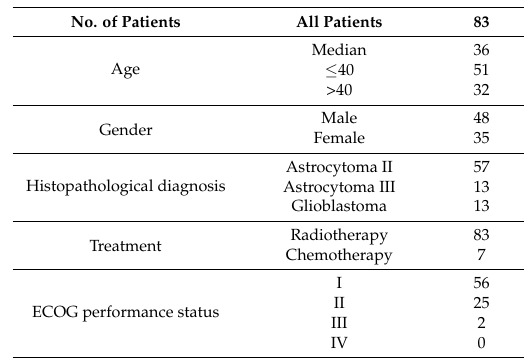
Table 1. Clinical features of the study population of 83 glioma